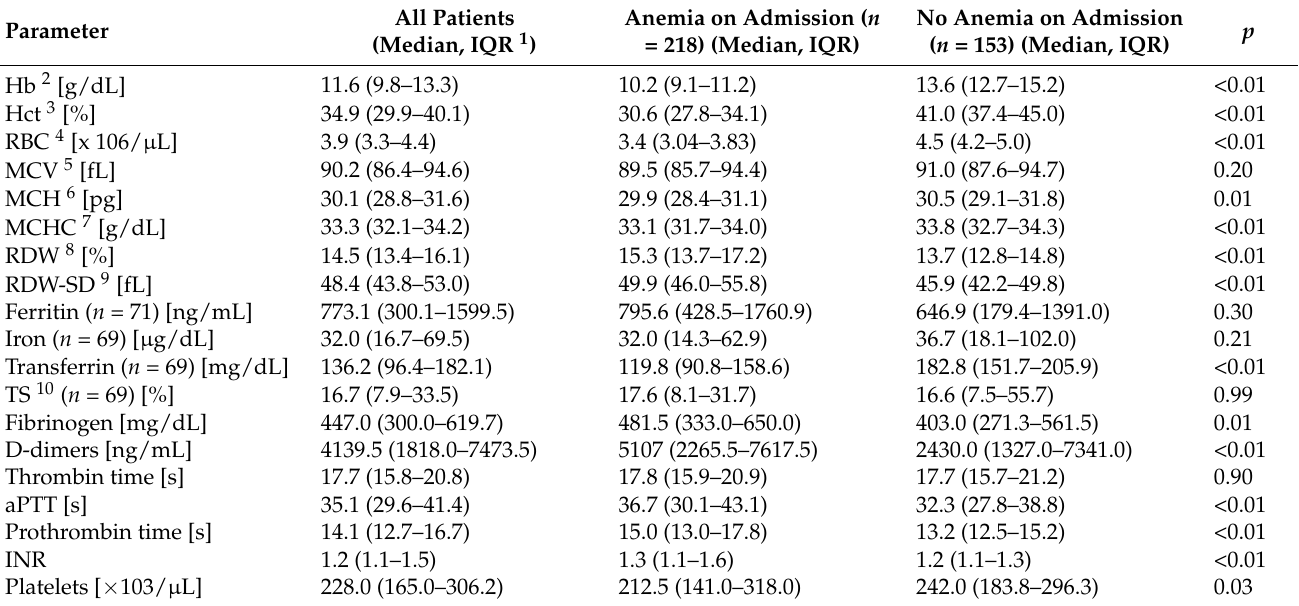
Table 2. Selected laboratory parameters in patients with and without anemia on admission to